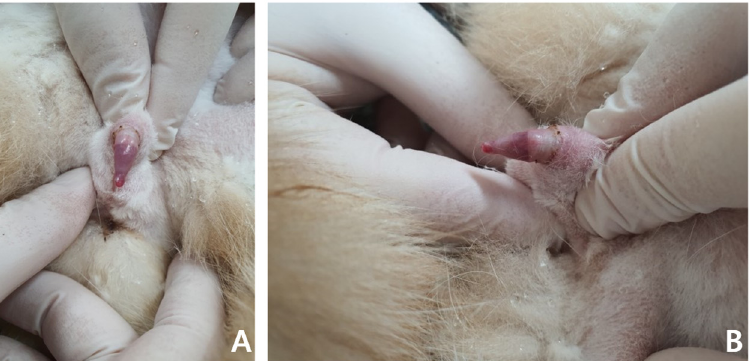
Figure 1. Non-ischemic priapism in a 14-year-old neutered male British shorthair. The penile tip is dry and shows a soft erection ( A , B ).